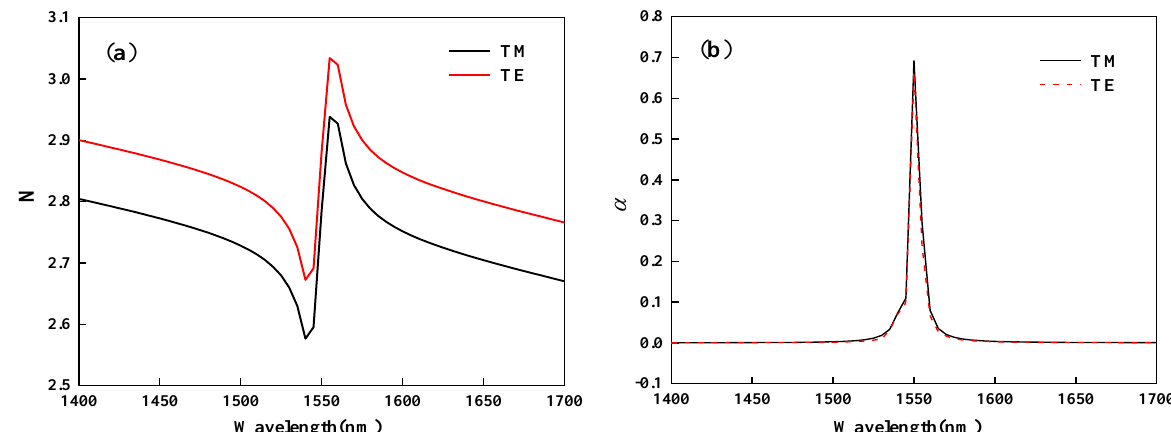
Figure 5. The real and imaginary parts of the effective refractive index changes in TE and TM modes at different wavelength ( a ) The real part of effective refractive index ( b ) The imaginary part of effective refractive index. is equal to 0.49 eV, 0.50 eV, 0.51 eV, 0.52 eV, and As shown in Figure 6, when c also increases as the 0.53 eV, the wavelength taken to the extinction coefficient max chemical potential increases. By choosing different chemical potentials, the device can maintain the high extinction coefficient over the wide range of wavelengths. At the same and are almost equal for the same chemical potential, time, the values of TM TE which again confirms the good polarization independence of the device.